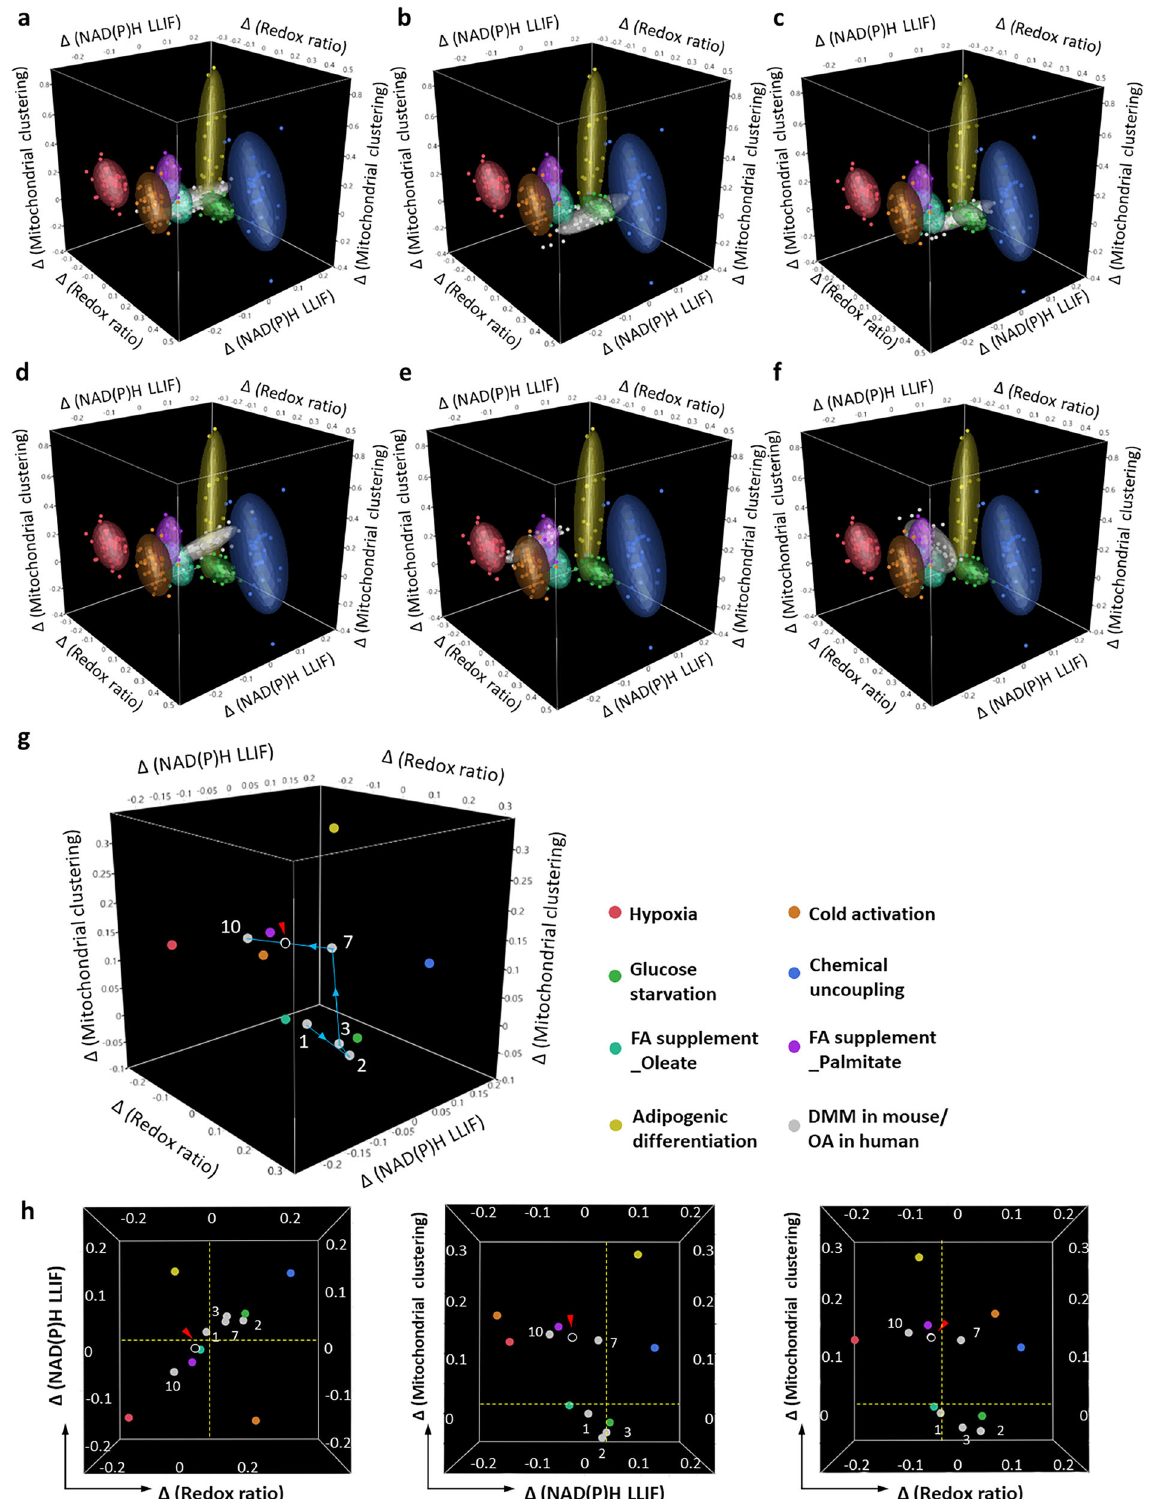
high-resolution, multi-modal two-photon imaging to assess at the same time the state of cellular function and matrix integrity. As anticipated, changes are primarily detected in the super fi cial zone, as shown in the schematic model that summarizes the structural and functional changes at early OA stages reported in this study (Fig. 7), highlighting the importance of spatial resolution. We identify signi fi cant changes as early as the fi rst week following